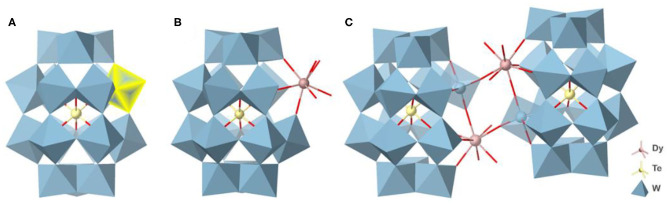
The polyhedral and ball-and-stick view of (A) {TeW18O62}, (B) {DyTeW17}, and (C) {Dy2Te2W34}. The cations and the lattice H2O molecules are omitted for clarity.